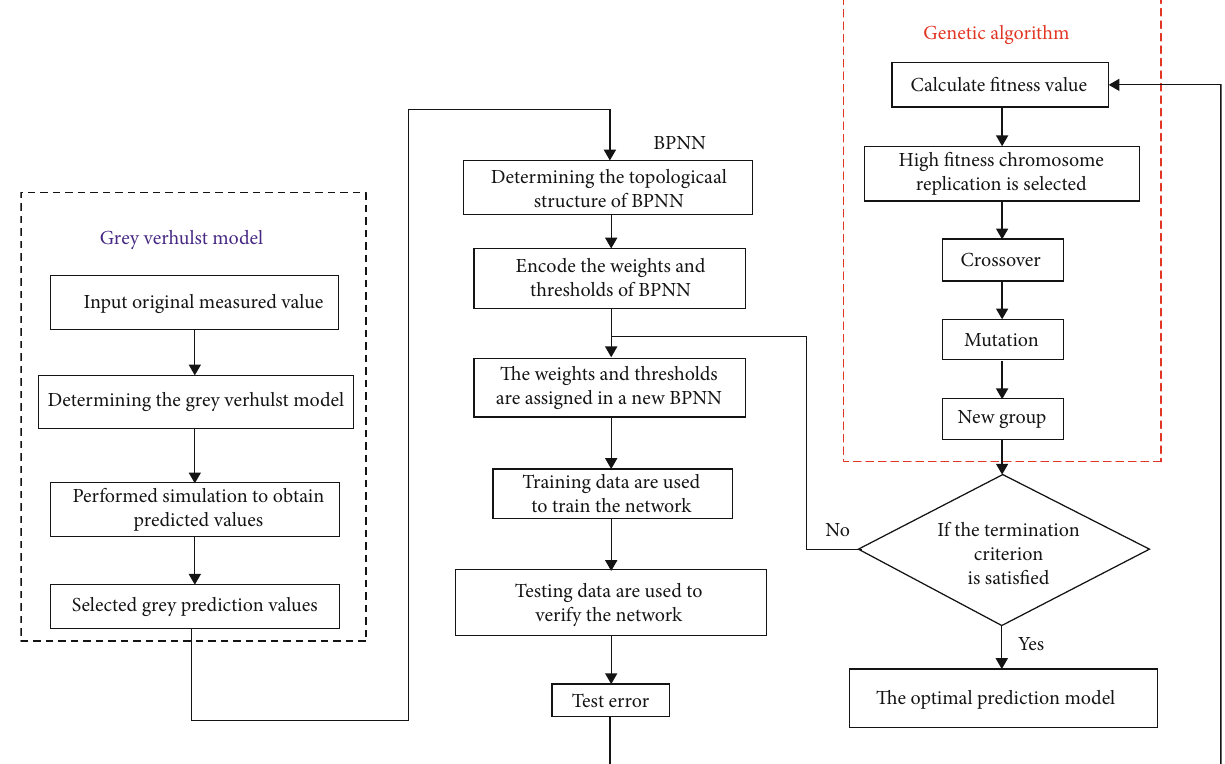
Figure 1: Flow chart of GA-BP neural network optimized by the grey Verhulst model.